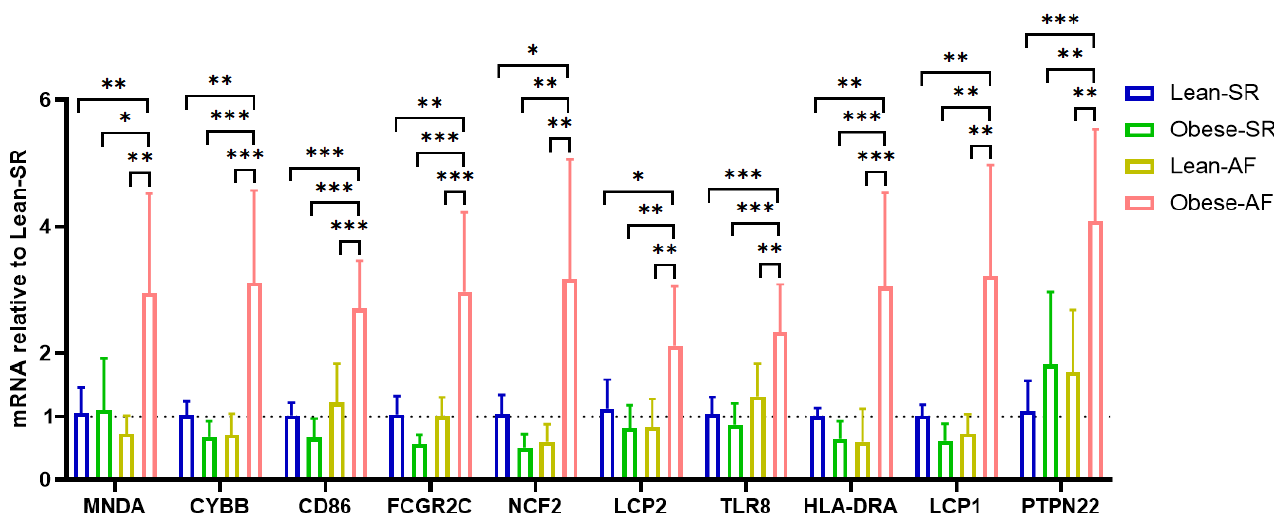
Figure 5. Validation of hub genes. Validation of hub genes in patients’ blood cells by qPCR, each of genes is relative to lean-SR group. * p < 0.05, ** p < 0.01, *** p < 0.001.